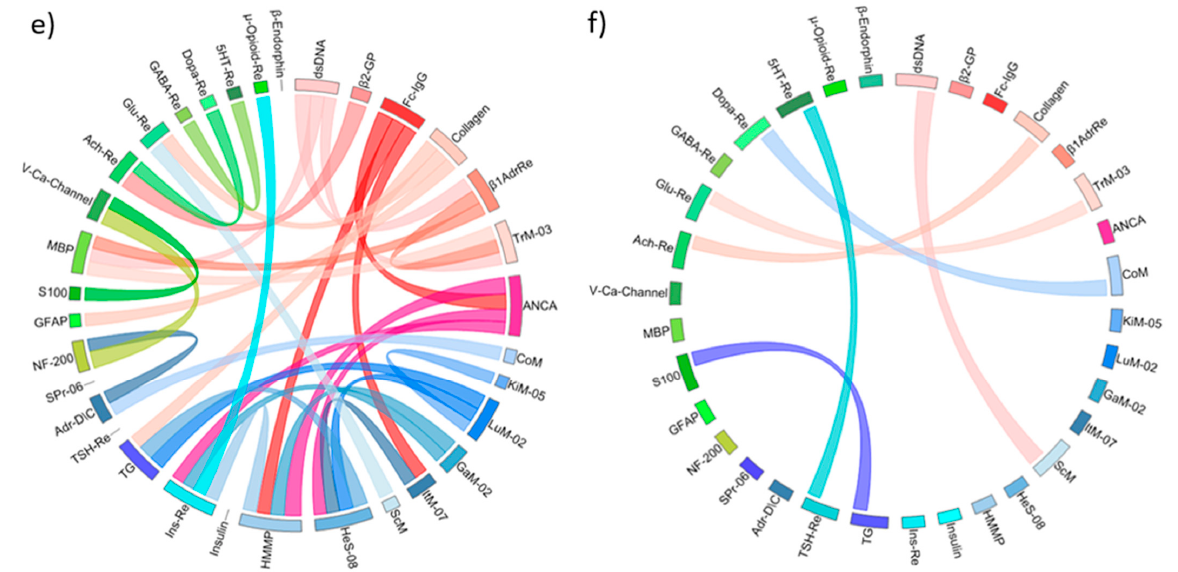
Figure 2. Chord diagrams illustrate the correlation matrices of AAb in the study cohorts. Segments in circles indicate studied AAb (see Table 1 for abbreviations employed), which are grouped according to the target antigen (red/pink = organ-specific, green = neural, blue = non-organ-specific antigens). Chords linking AAb indicate significant correlations (at least p < 0.05) according to Spearman rank correlations, while chord thickness is directly proportional to correlation coefficient. For clarity, positive and negative correlations are shown separately. ( a ) Positive correlations, ME/CFS(+)FM; ( b ) Negative correlations, ME/CFS(+)FM; ( c ) Positive correlations, ME/CFS(-)FM; ( d ) Negative correlations, ME/CFS( − )FM; ( e ) Positive correlations, HC; ( f ) Negative correlations, HC.